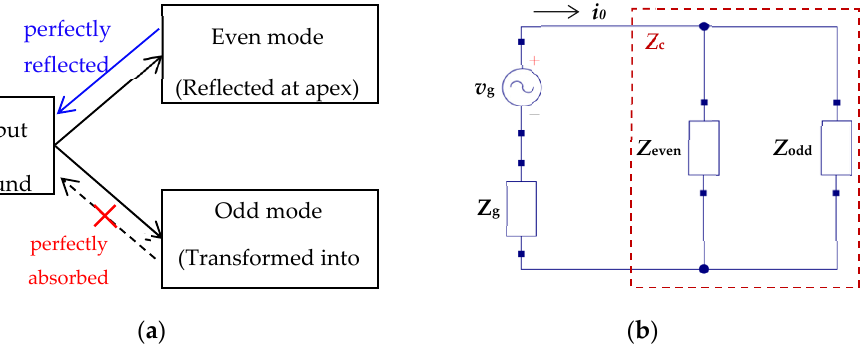
Figure 8. An equivalent circuit of the cochlea. ( a ) Contributions of the even and odd sound wave modes to the cochlear acoustics. ( b ) an equivalent circuit of the cochlea designed based on transmis- sion line theory.